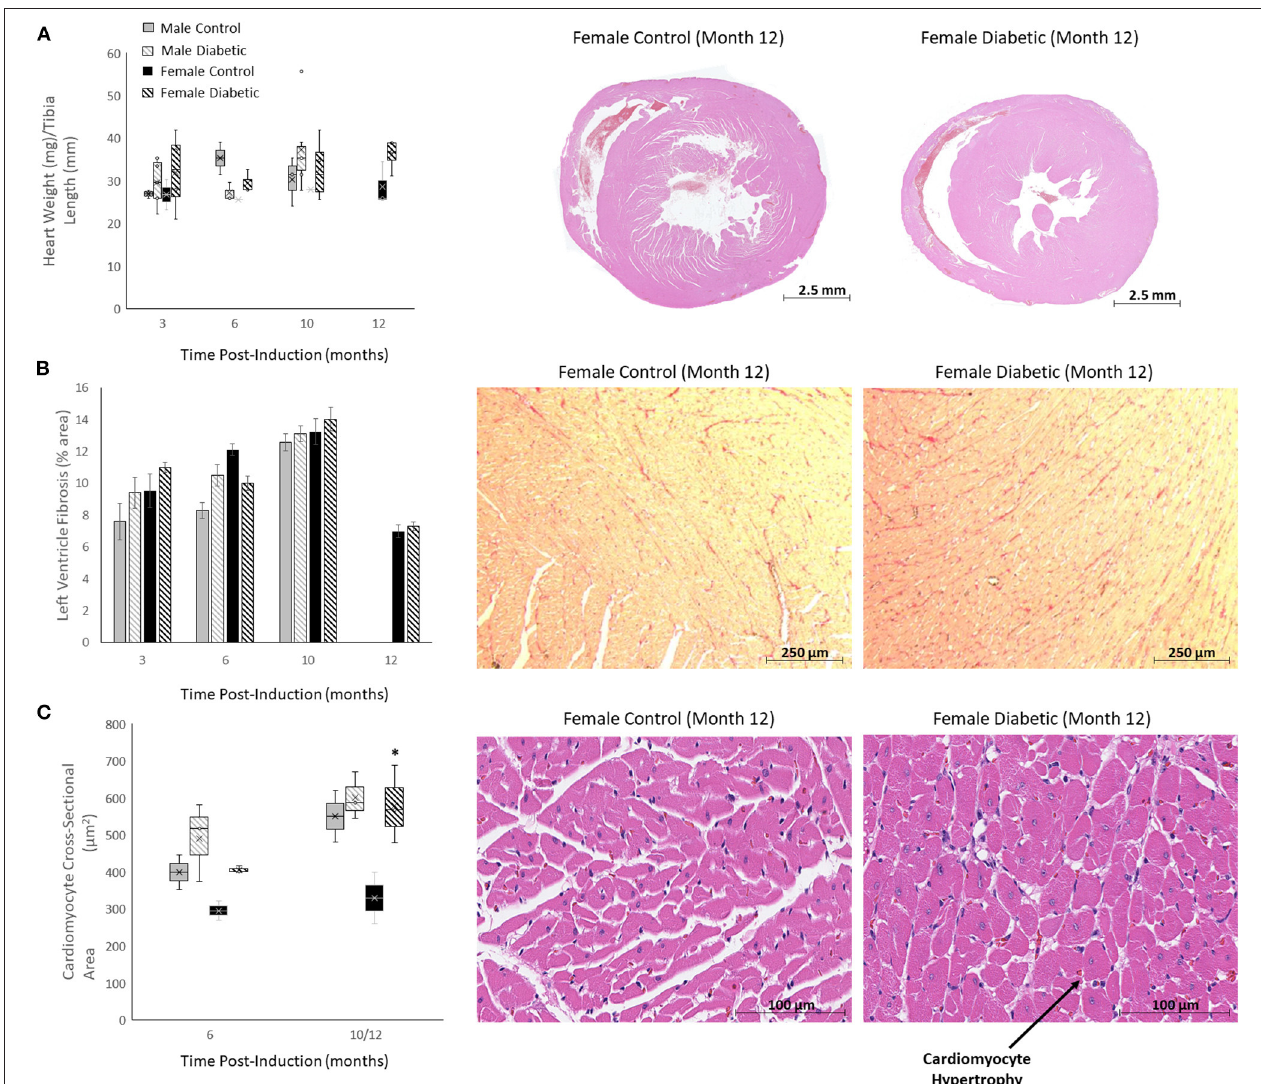
FIGURE 8 | Histology of non-vascular markers in the heart. Timepoints refer to time post-induction at 3 months ( n = 2 control male, n = 8 diabetic male, n = 2 control female, n = 3 diabetic female), 6 months ( n = 2 control male, n = 3 diabetic male, n = 2 control female, n = 3 diabetic female), 10 months ( n = 5 control male, n = 9 diabetic male, n = 2 control female, n = 3 diabetic female) and 12 months ( n = 3 control female and n = 3 diabetic female). (A) Heart weight-to-tibia-length ratio (left), and H&E slide scans at 12 months post-induction of control and diabetic females (right). (B) Interstitial fibrosis quantified as percentage of collagen surface area coverage on stained heart sections (left), and representative images of control and diabetic female heart tissue stained for collagen at 12 months post-induction at 10x magnification (right). (C) Cardiomyocyte cross-sectional area quantified at 6 and 12 months post-induction (left), and representative images of control and diabetic female heart tissue stained with H&E at 12 months post-induction at 40x magnification (right). Histology images for male cohort is found in reference (8). Boxplot mean value is represented with the symbol “X.” Significance at individual timepoints between control and diabetic cohorts of the same sex is indicated (* p < 0.05). Data represented as mean ±